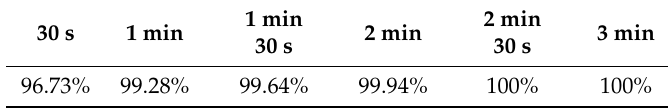
Table 8. Accuracy of final fire decision after majority voting with respect to T vot